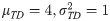
Phasic fluctuations generate ramping signals.(A) Average dopamine concentration [DA] (±SEM) aligned to time of threshold crossing. Number of simulated trials N = 1000. (B) Time of threshold-crossing (latency) is negatively correlated with size of TD error h in the model (ρ = −0.43). (C) Similarly, response magnitude of dopaminergic cells to a trial-start cue (upper plots, showing population response histograms by behavioural reaction time, RT) is negatively correlated with a monkey’s reaction time (lower) in an instrumental, reward-related task. Adapted from [83], with permission. [DA] process parameters: dt = 0.01 s, θ = 1, κ = 0.01, σ = 0.1. DDM parameters: A = 2, c = 0.1, z = 5. TD errors: μTD=4,σTD2=1.